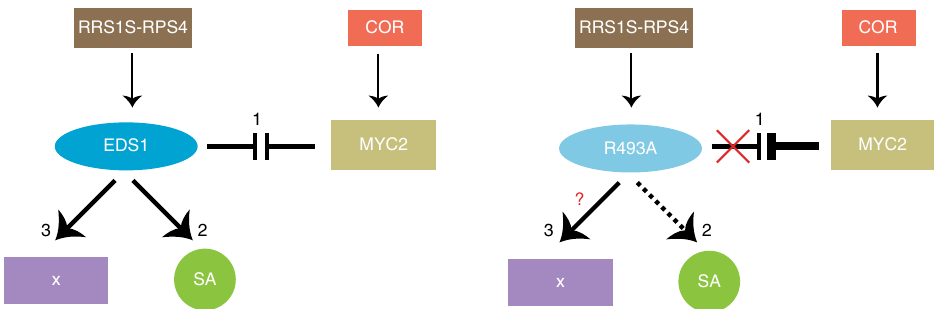
Fig. 7 A model of EDS1 signalling branches in RRS1S RPS4 ETI. A three-pronged ETI signalling model derives from comparisons of wild-type EDS1, EDS1 R493A and eds1-2 phenotypes in this study. Three interconnected EDS1 outputs contribute to robust TNL ETI: (1) TNL-activated wild-type EDS1 effectively counters COR antagonism of immunity gene expression via MYC2. The defective EDS1 EP-domain mutant R493A is susceptible in TNL ETI against Pst AvrRps4 due to its inability to counter COR/MYC2 antagonism. (2) Wild-type EDS1 boosts SA accumulation independently of antagonising MYC2 while EDS1 R493A delays SA accumulation (dashed lines) independently of COR repressive effects. (3) An additional EDS1 branch (X) in TNL ( RRS1S